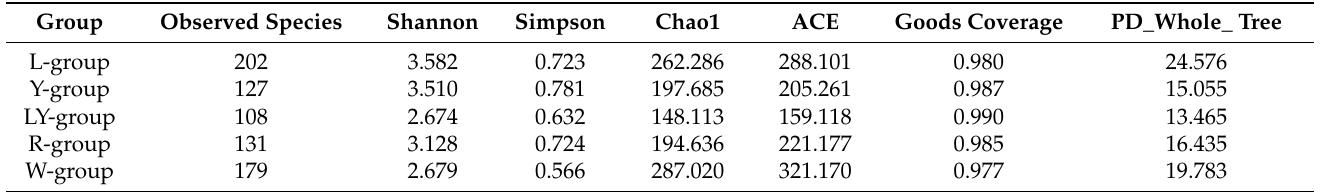
Table 4. Alpha indices statistics of intestinal microbial diversity in different experimental groups (L-group, Y-group, LY-group, R-group and